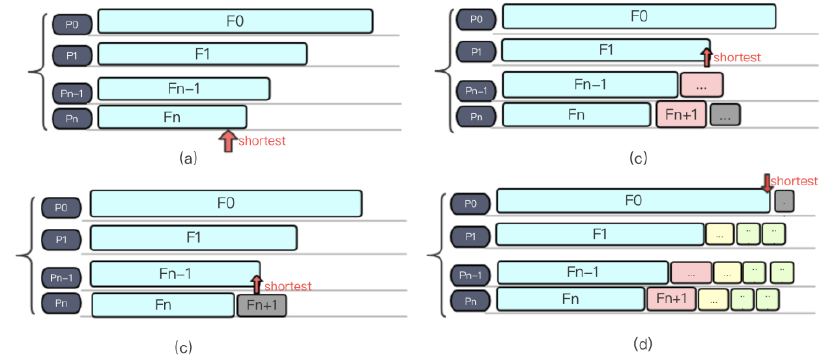
Figure 9. A demonstration of the Short-Board load balancing algorithm.